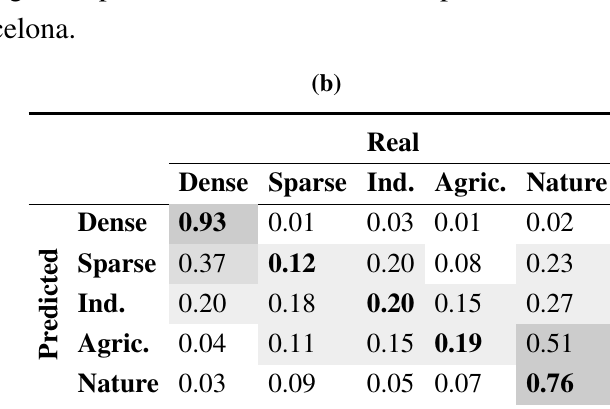
Table 6. Confusion matrix of München and Barcelona with the five classes (dense residential, sparse residential, industrial, agricultural, nature); result obtained with a cross-city model with background knowledge sampled with SCi.SCl and 50